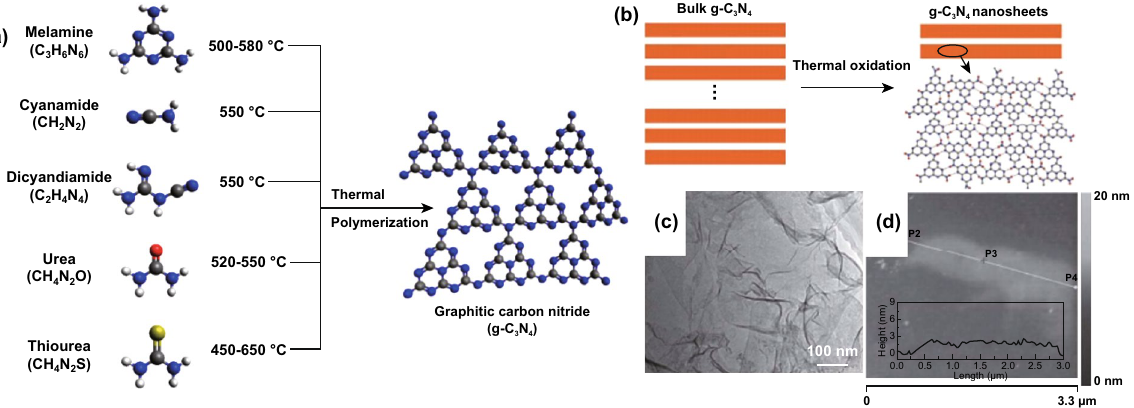
Fig. 10 a Schematic illustration of one of the top-down synthesis approach (thermal polymerization) for g-C 3 N 4 using different precursors. Black balls—carbon (C), blue balls—nitrogen (N), white balls—hydrogen (H), red balls—oxygen (O), and yellow balls—sulfur (S), respectively. Reproduced with permission from Ref. [84]. b Schematic of the synthesis of g-C 3 N 4 nanosheets from bulk g-C 3 N 4 . In the atomic model, carbon atoms—gray balls, nitrogen atoms—blue balls and hydrogen atoms—red. c TEM image of g-C 3 N 4 nanosheets. d Tapping-mode AFM image of a single g-C 3 N 4 nanosheet deposited on the silicon wafer substrate. The inset is the height curve determined along the line between P1 and P4. Reproduced with permission from Ref. [88]. Copyright permissions from American Chemical Society and Wiley–VCH. (Color figure